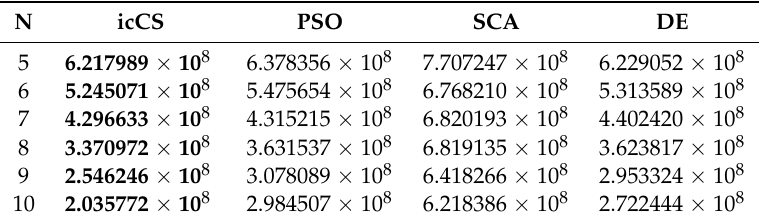
Table 8. The results of the algorithm proposed in this paper and other algorithms on the location of the drone logistics hub in Model